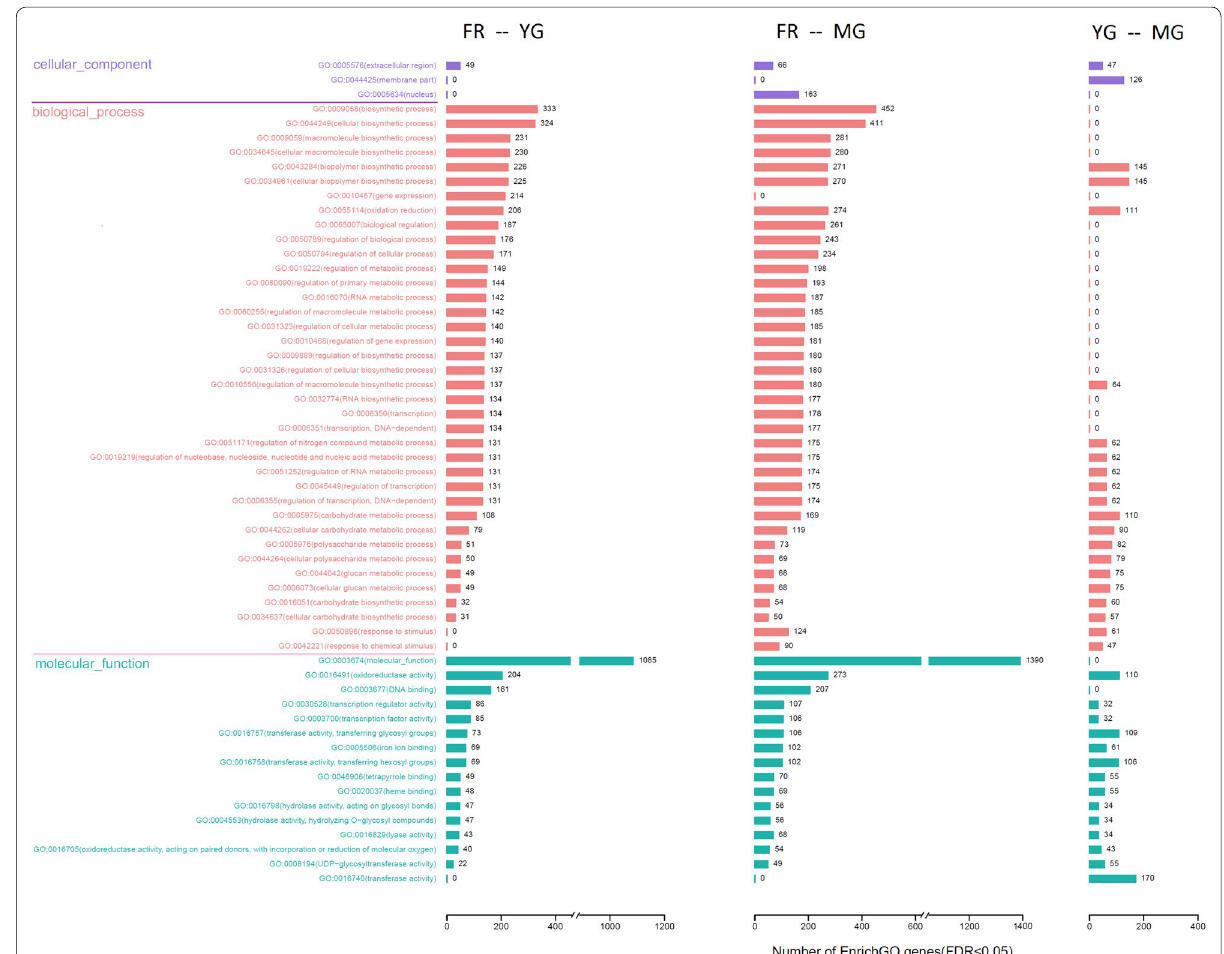
Fig. 3 Gene ontology (GO) enrichment of differentially expressed genes (DEGs) between ginger matured rhizome, young rhizome, and fibrous root libraries. P values are represented along the x-axis and level two GO terms belonging to three categories, molecular function, biological process, and cellular component are represented along the y-axis. Numbers indicate the number of unigenes assigned to each